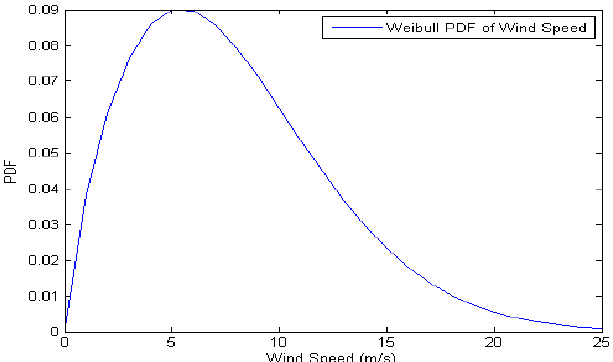
Figure 2. Weibull probability density function (PDF) of wind speed.